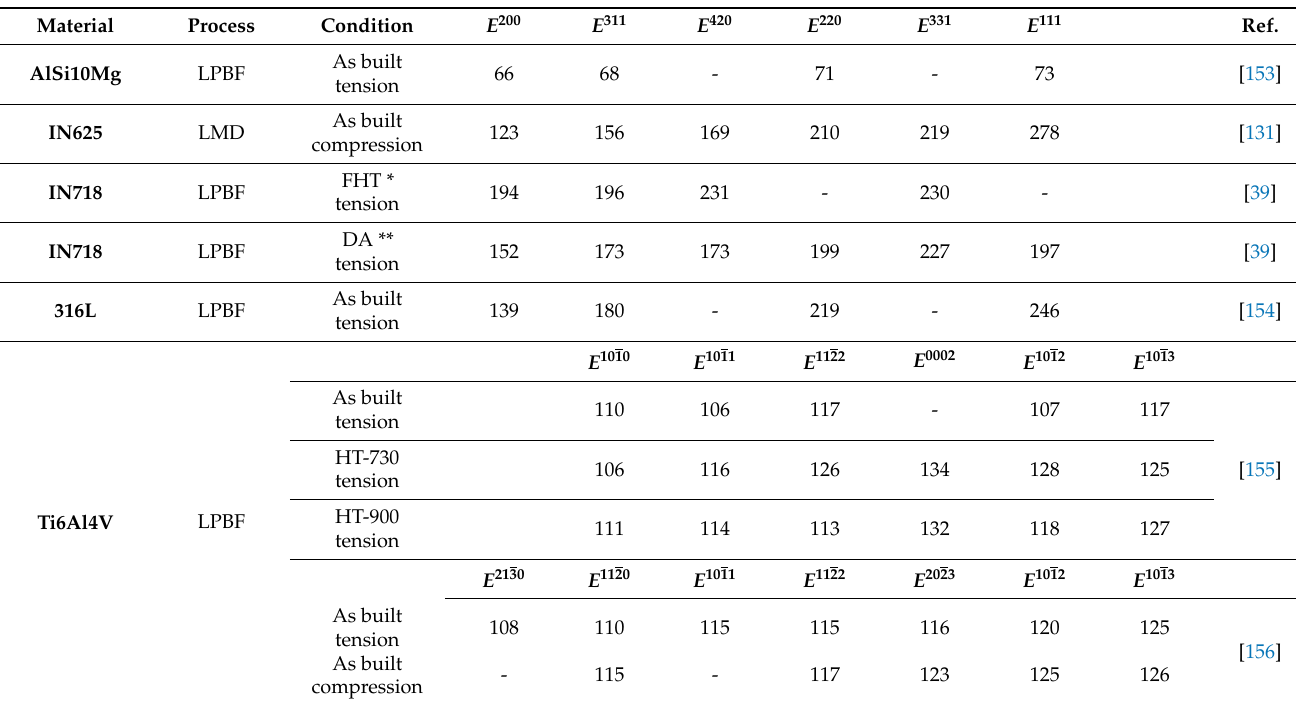
Figure 11. Overview of different model approaches for the calculation of the diffraction elastic constants. ( a ) Voigt Table 3. Experimentally determined diffraction elastic constants by the means of diffraction methods. The plane-specific elastic moduli ( E hkl ) are given in